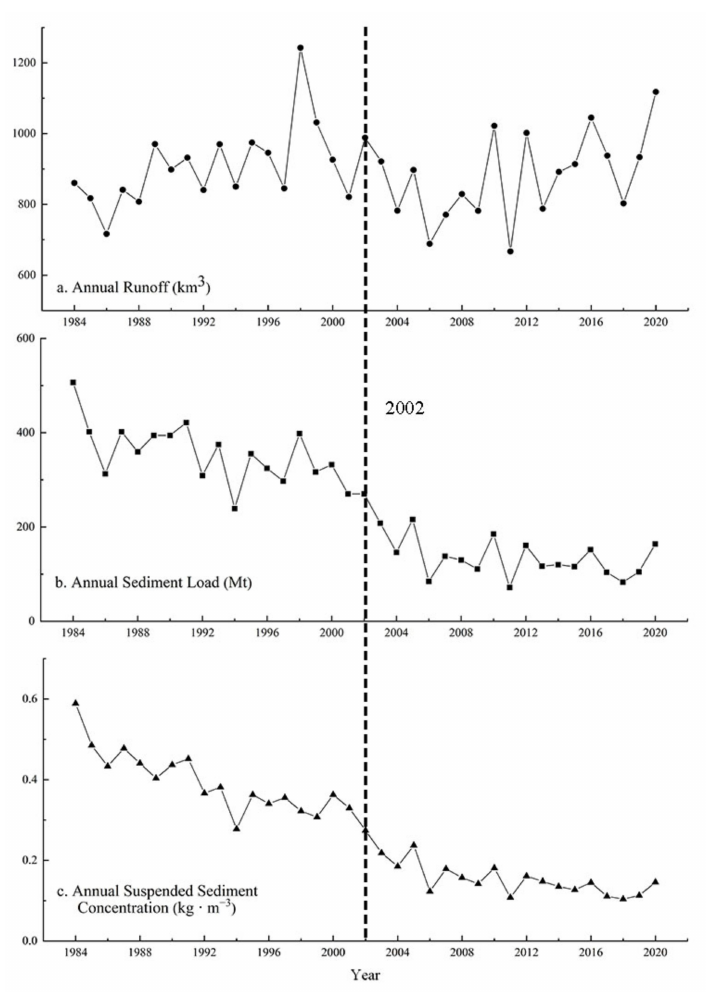
Figure 6. Annual runoff ( a ), annual sediment load ( b ), and annual suspended sediment concentration ( c ), before (left side of the dashed line) and after (right side of the dashed line) the three gorges project became operational. Data measured at Datong Station from 1984 to